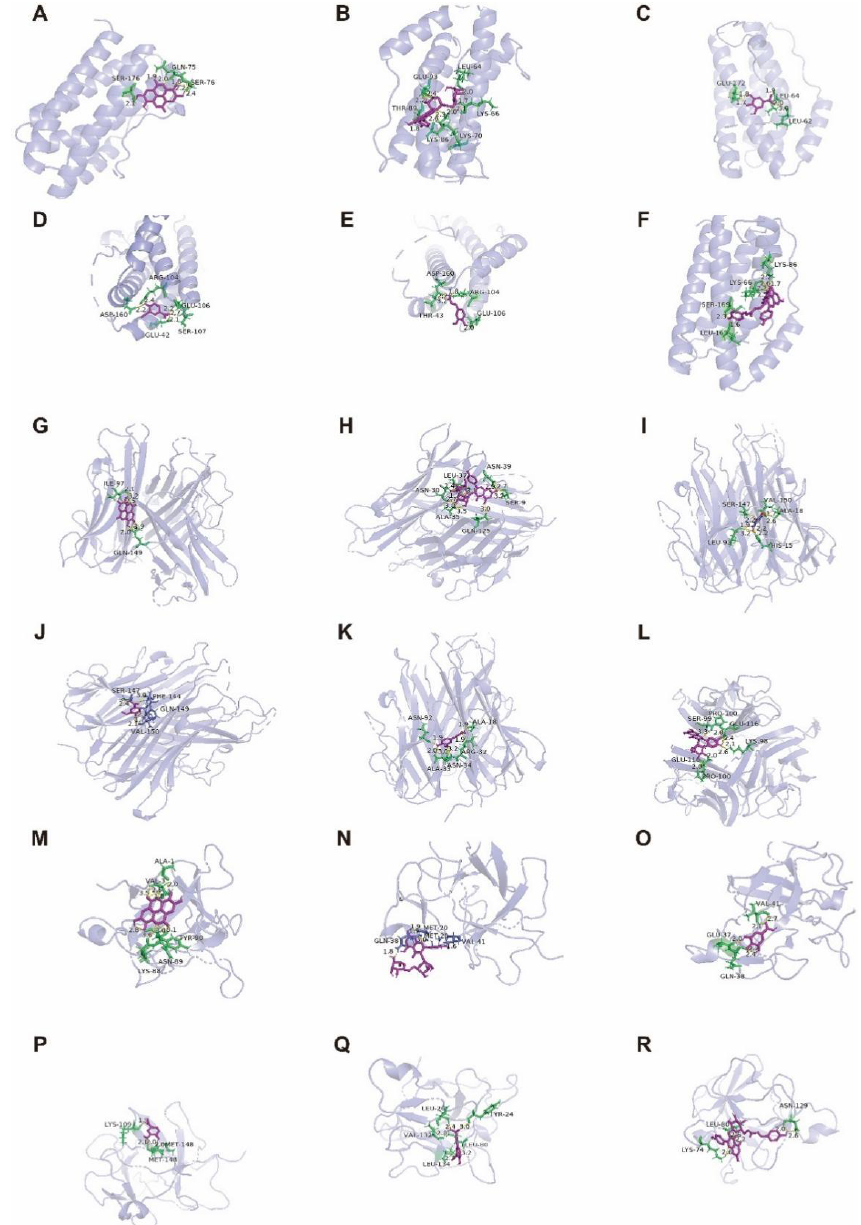
Figure 13. Molecular docking diagram of Ellagic acid ( A : EA), Kaempferol-3-o-rutin glycoside ( B : KA) , Gallic acid ( C : GA), Vanillic acid ( D : VA), Ferulic acid ( E : FA), and Tiliroside ( F : TI) with IL-6 ( A to F ). Ellagic acid ( G : EA), Kaempferol-3-o-rutin glycoside ( H : KA), Gallic acid ( I : GA), Vanillic acid ( J :VA), Ferulic acid ( K :FA), and Tiliroside ( L : TI) with TNF- α ( G to L ), and Ellagic acid ( M : EA), Kaempferol-3-o-rutin glycoside ( N : KA), Gallic acid ( O : GA), Vanillic acid ( P : VA), Ferulic acid ( Q : FA), and Tiliroside ( R : TI) with IL-1 β ( M to R ) target proteins.